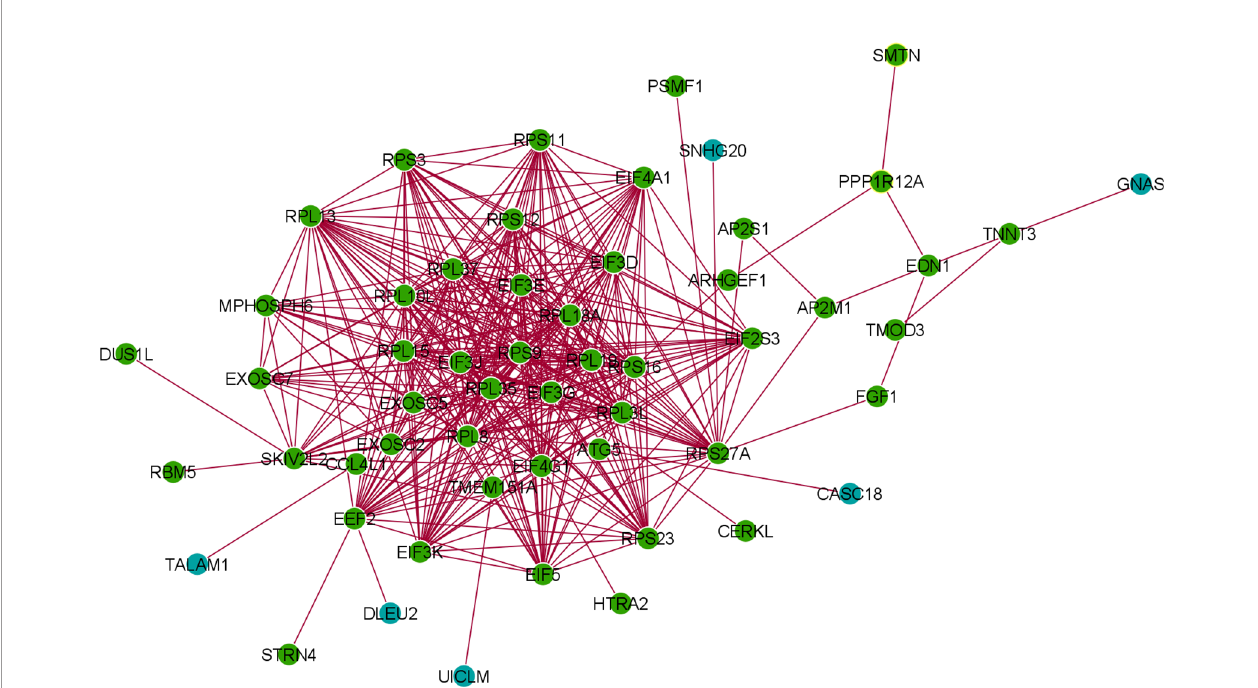
FIGURE 11 | The co-expression networks of the protein expression genes of DEG and